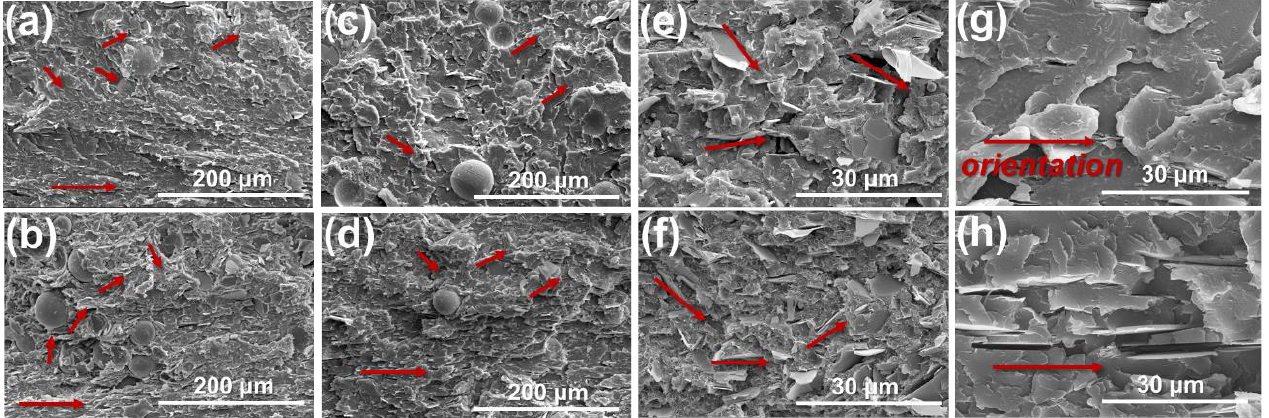
Figure 5. The microstructure of PC-based composites along the flow direction: ( a ) PC/A L 40B5, ( b ) PC/A L 40B20, ( c ) PC/A L 20B5, ( d ) PC/A L 20B20, ( e ) PC/A S 40B5, ( f ) PC/A S 40B20, ( g ) PC/B5; ( h ) PC/B20.